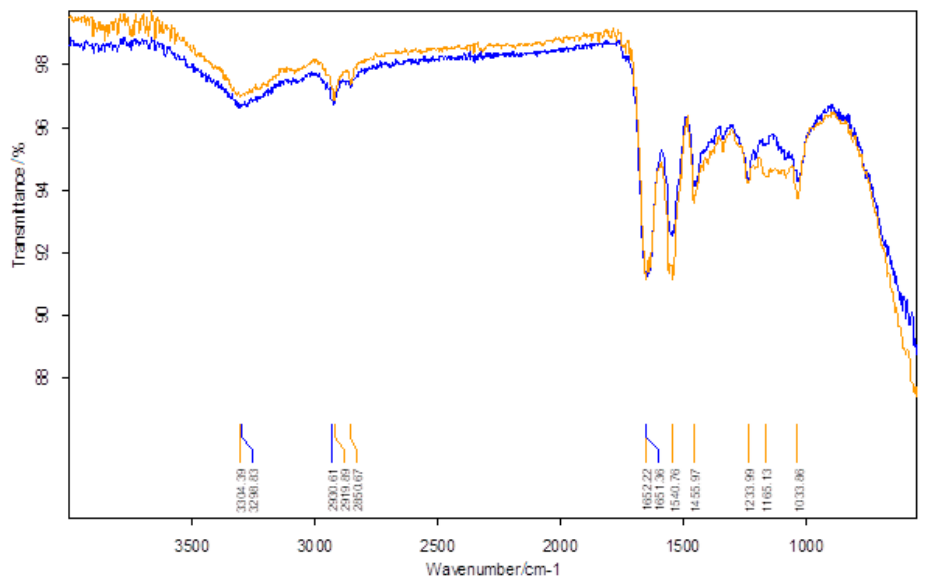
Figure 18. FTIR analysis: BPA untreated skin (blue) and BPA treated skin (brown).